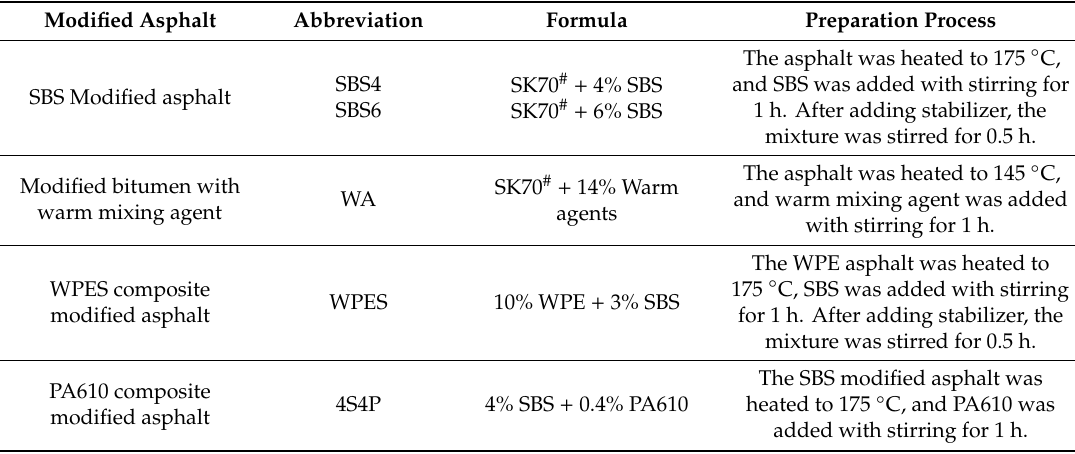
Table 1. Modification scheme of modified